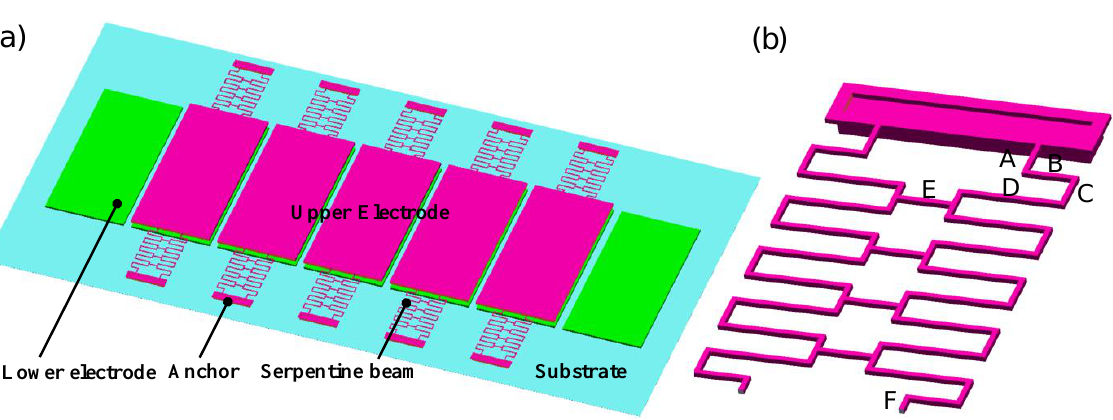
Figure 1. ( a ) Lateral view of the out-of-plane actuator schematic. Cyan represents the substrate layer, green represents the first polysilicon layer (bottom layer), pink represents the second polysilicon layer (top layer); ( b ) Lateral view of the serpentine beams on the second polysilicon layer, A–F illustrate different segments for structural